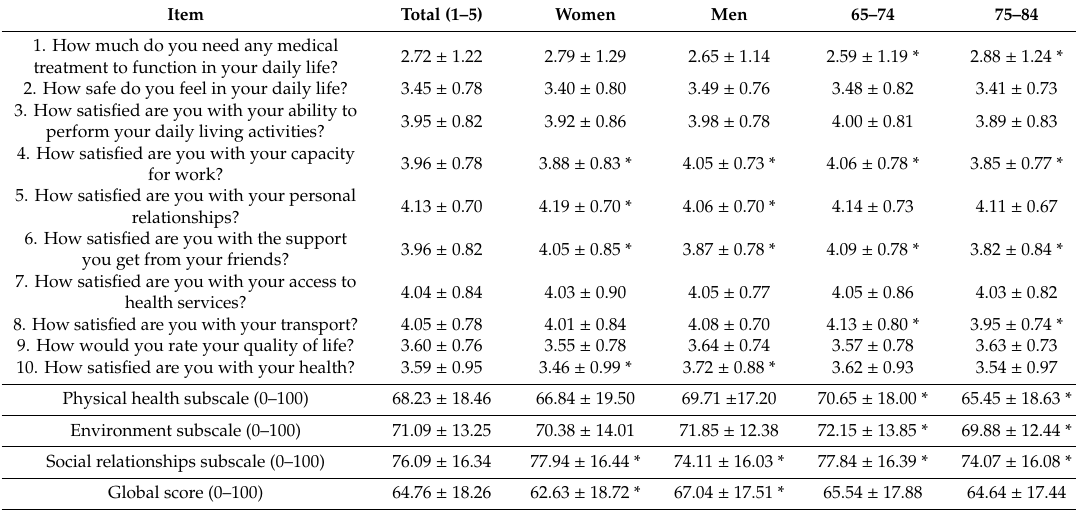
Table 2. Average scores for each of the ten items on the WHOQoL BREF scale that assess satisfaction in some aspects of